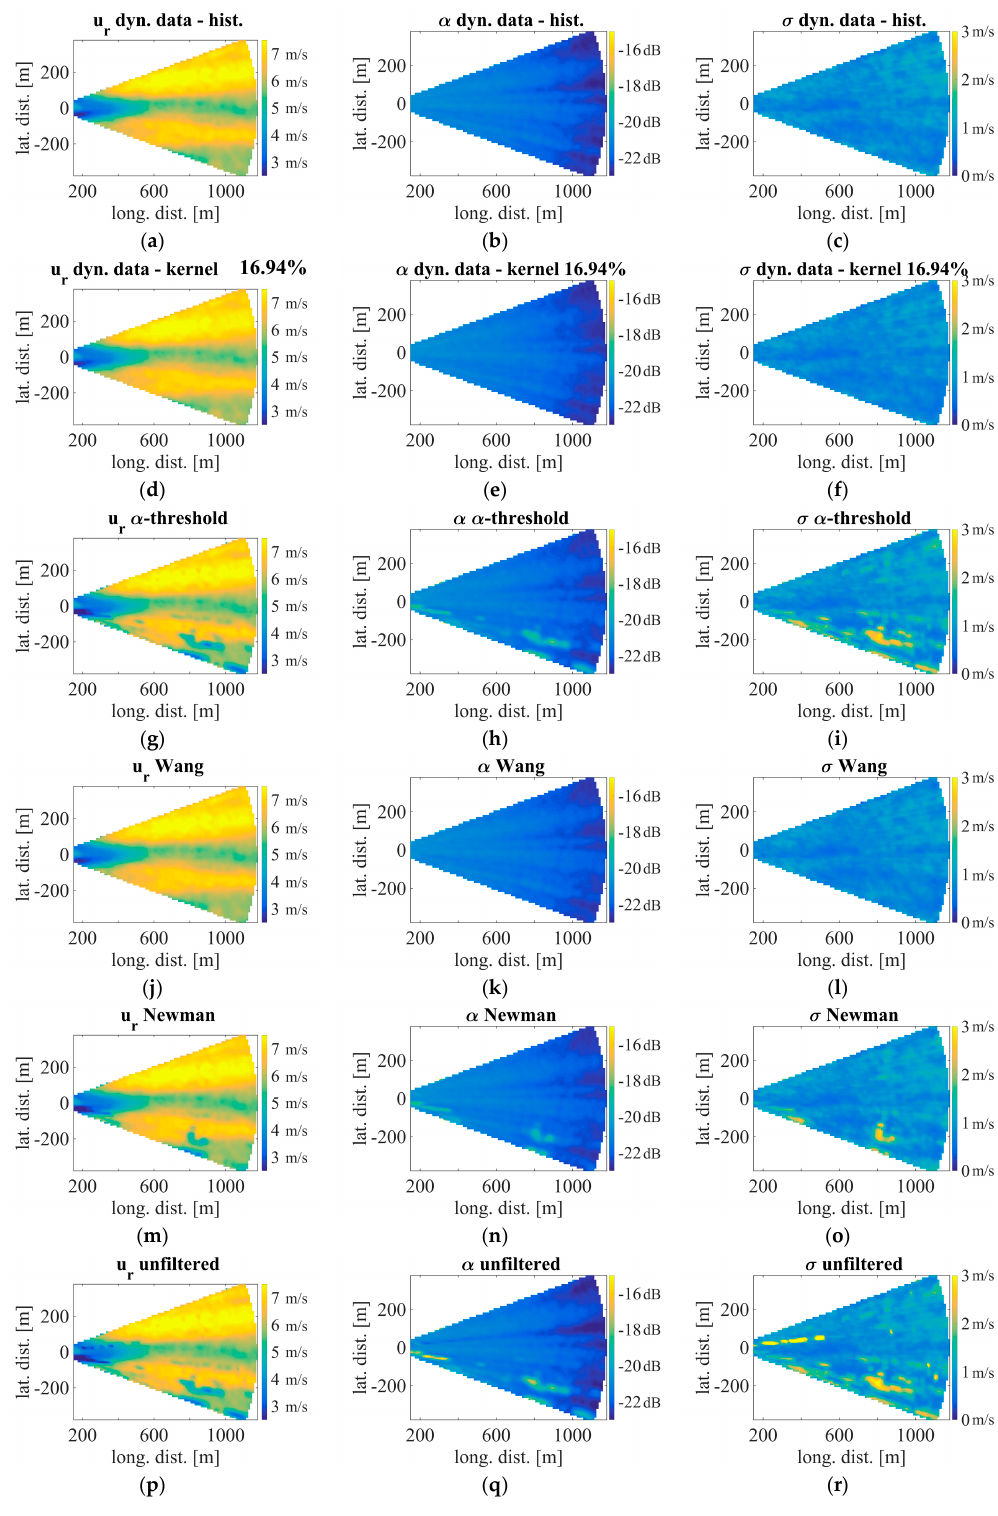
Figure 16. Influence of different filtering methods on a 10 min averaged horizontal LiDAR scans. ( 1st column ) radial speed, ( 2nd column ) CNR mapping, ( 3rd column ) standard deviation of radial speed. ( a – c ) histogram-based dynamic data filter, ( d – f ) Gaussian kernel based dynamic data filter, ( g – i ) CNR-threshold filter, ( j – l ) combined filter approach by Wang et al., ( m – o ) combined filter approach by Newman et al., ( p – r ) unfiltered.